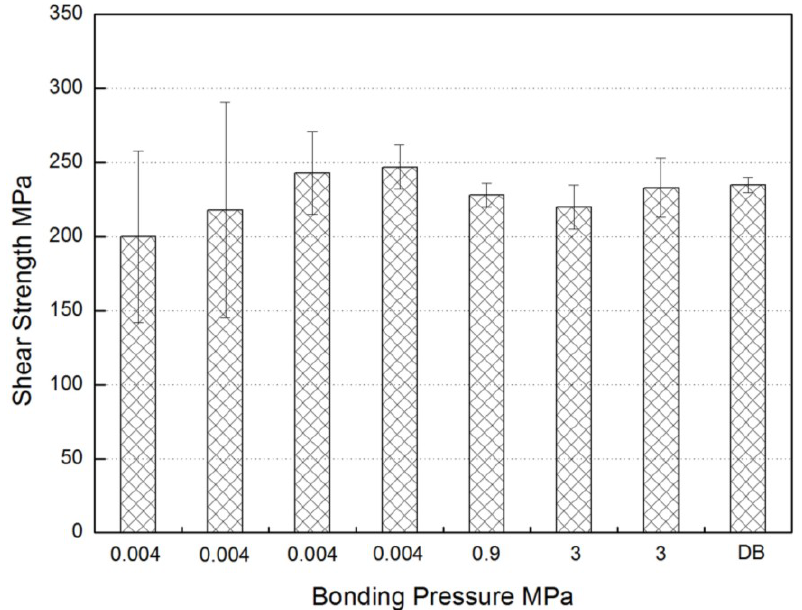
Figure 2. Effect of gap size on the shear strength of joints between γ-Met sheets, brazed with Ti-Cu-Ni powder at 1040 °C for 600 s. Data from a solid state diffusion bond (1050 °C for 14.4 ks with 40 MPa pressure) is also shown. The error bars represent two standard deviations from the average value. (Reprinted with permission from